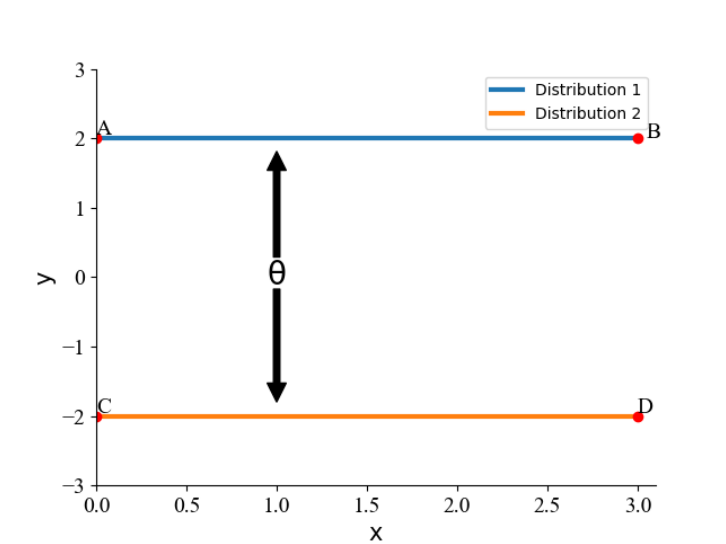
Figure 3. Schematic diagram of the two different distributions.